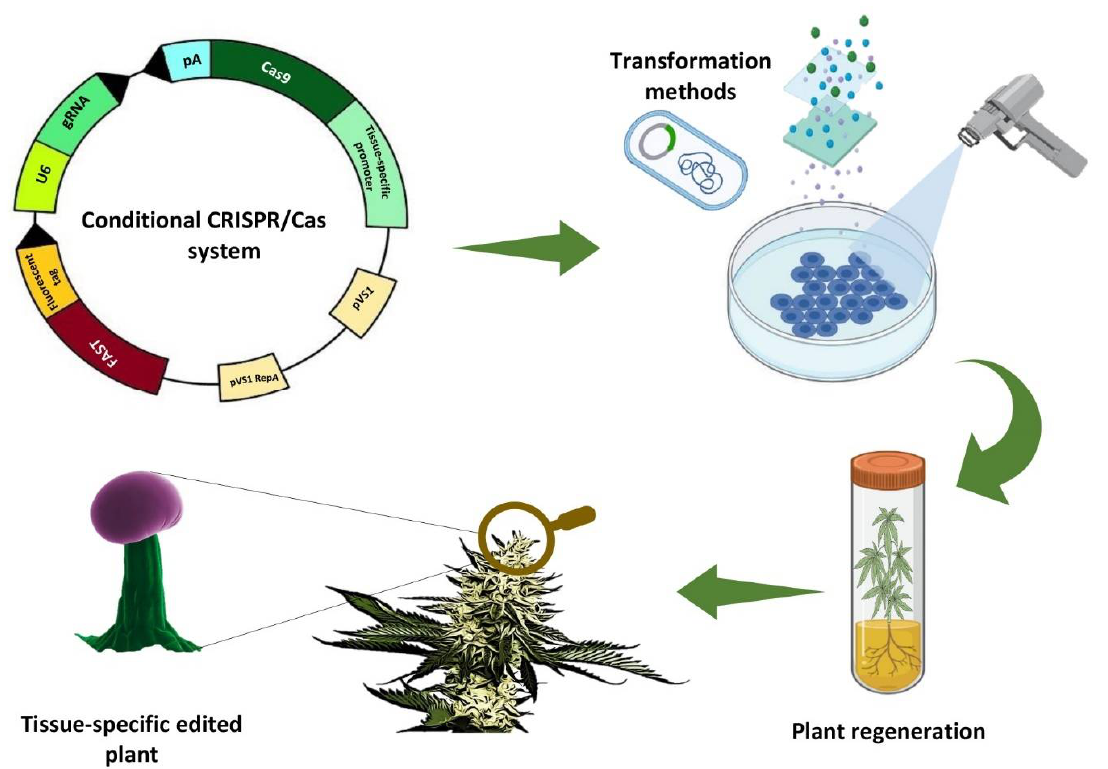
Figure 6. A schematic view of Conditional CRISPR/Cas methodology for producing ornamental cannabis.